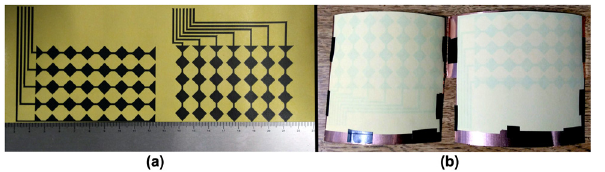
Figure 3: The pattern is printed in a tone transfer paper ( a ) and then positioned over the copper foil tape ( b ) .